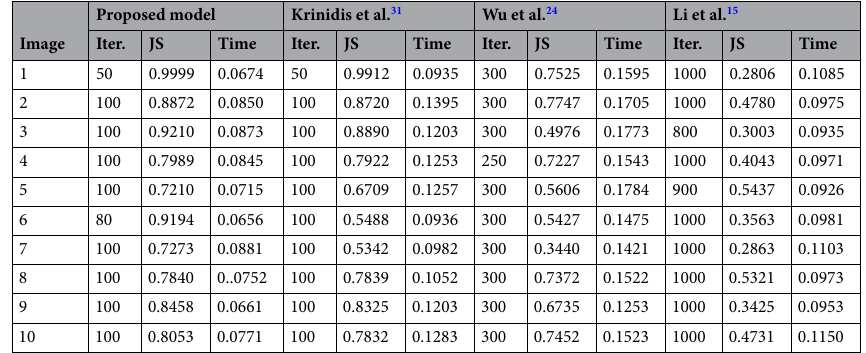
Table 1. Jaccard similarity measure, number of iterations and CPU time (second) of Krinidis et al. 31 , Wu et al. 24 , Li et al. 15 and of our proposed model on 10 images from Berkeley’s data set, image size 110 × 110.